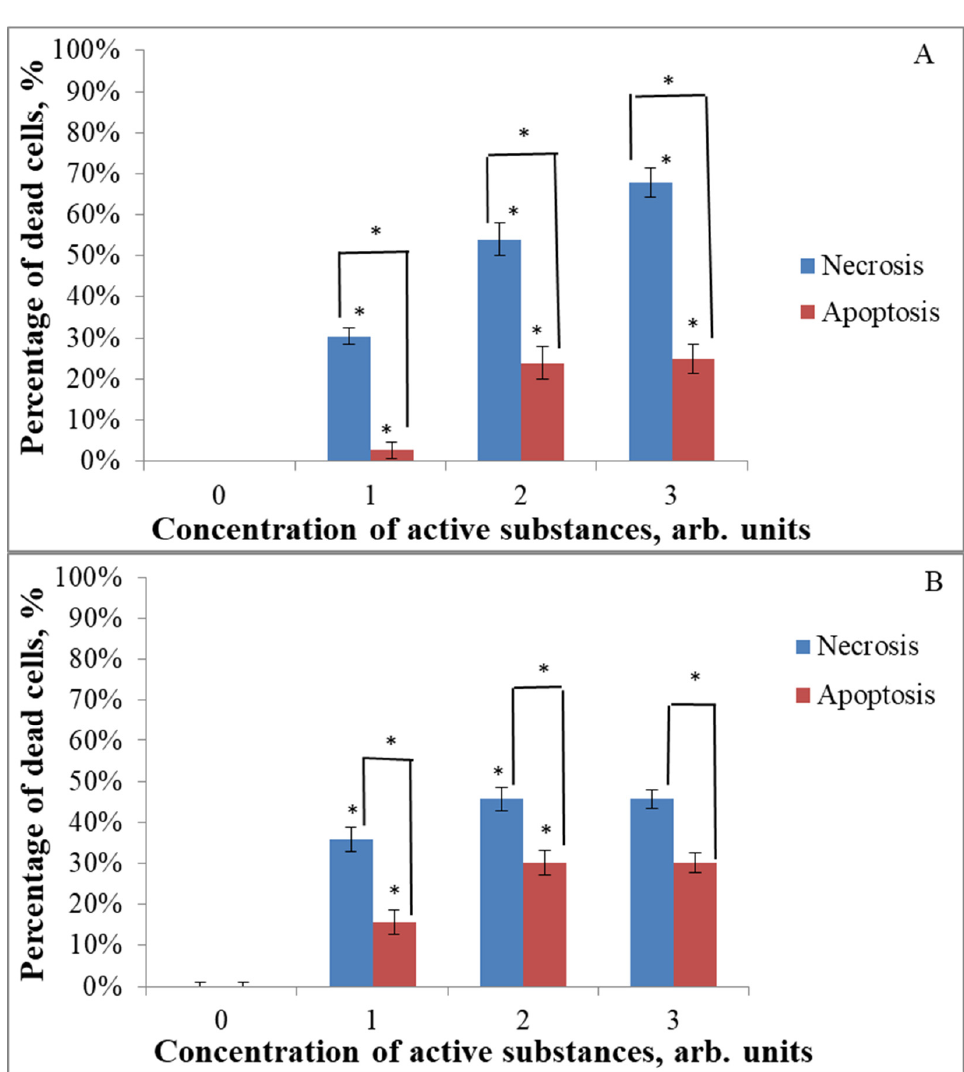
Figure 11. Distribution of types of death of ( A ) conventionally healthy and ( B ) tumor (mieloblastosis) cells at different concentrations of nitrites, nitrates, and hydrogen peroxide added to the nutritional medium. Concentrations 1–3 correspond to those in the physiological solution treated by the direct piezodischarge during 30, 60, and 90 s, respectively (1: H 2 O 2 —2.08 µM, NO 2 − —0.058 mM, NO 3 − —0.286 mM; 2: H 2 O 2 —6.91 µM, NO 2 − —0.091 mM, NO 3 − —0.378 mM; 3: H 2 O 2 –10.08 µM; NO 2 − —0.103 mM, NO 3 − —0.725 mM). An asterisk * indicates a statistically significant difference ( p < 0.05) from the control, an asterisk above the frame indicates a statistically significant difference ( p < 0.05) between different experimental samples. The experimental conditions are described in the Section 2